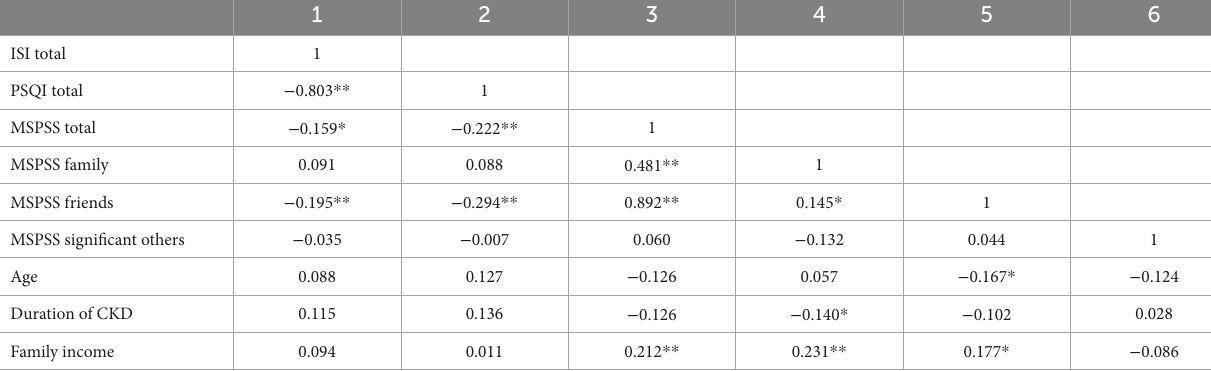
TABLE 3 Correlation between perceived social support measures and demographics and